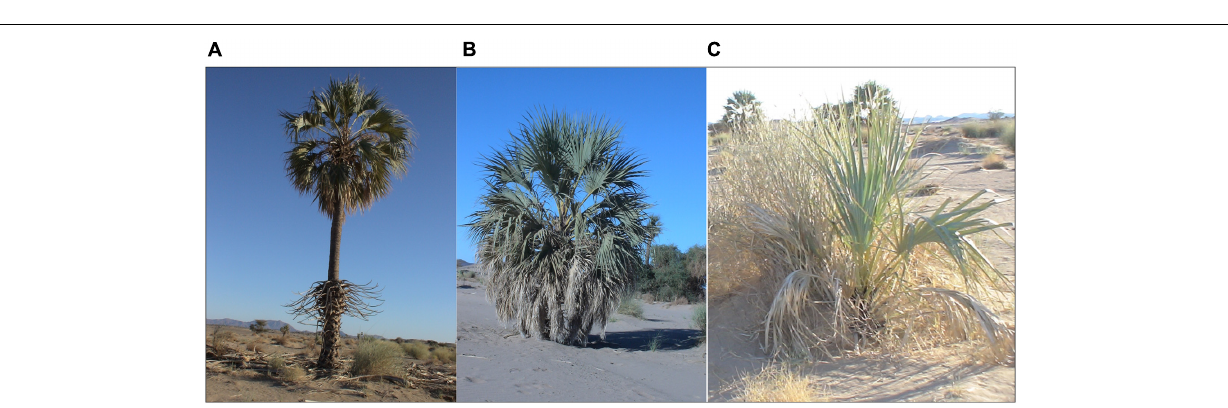
FIGURE 3 | Examples of the age classes: (A) old, (B) middle-age, and (C)